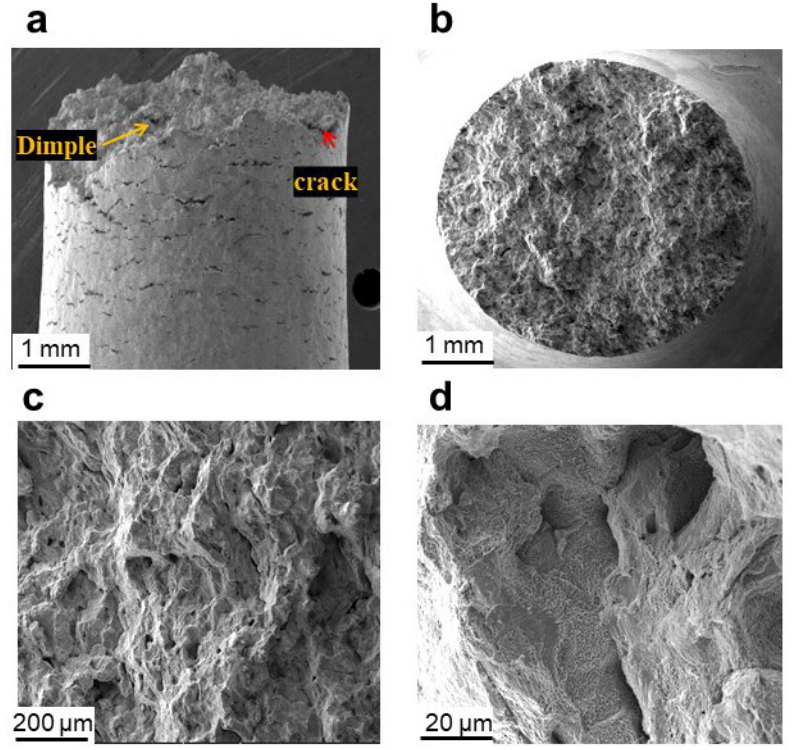
Figure 9. Fracture surface characterization of tensile failed 1175-AC samples by using SEM: ( a ) the side surface of the fracture sample; ( b ) the front view of the fracture sample; ( c , d ) the morphology of fracture surface under different magnifications.